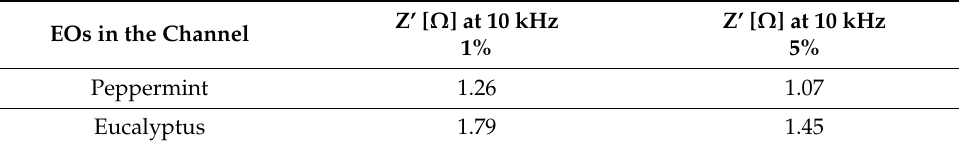
Table 2. Effect of concentration of EOs on the electrical resistance of microfluidic chip at 10 kHz.